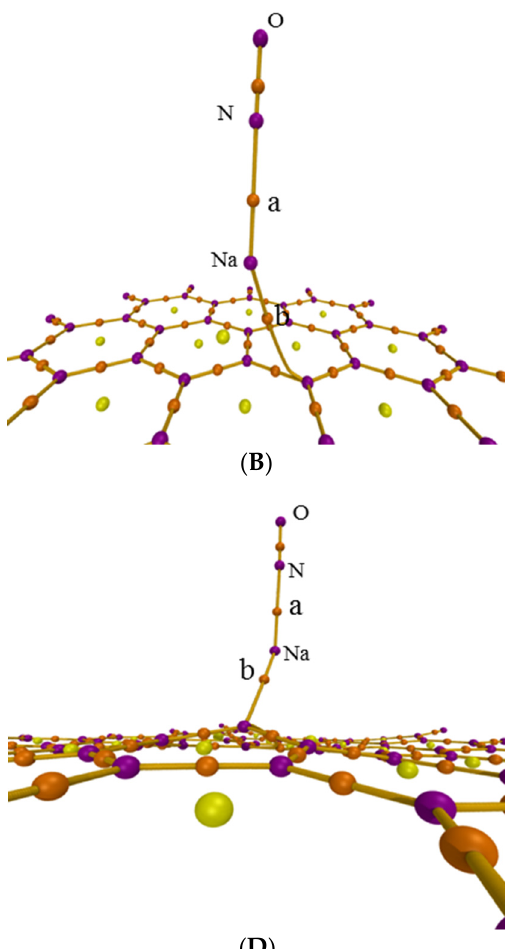
Figure 2. Optimized structure of ( a ) graphene-NO, ( b ) graphene-Na-NO, ( c ) gsv-NO, and ( d ) gsv-Na-NO. (The gray solid spheres indicate that the graphene surface and the purple, red, and blue spheres represent sodium, oxygen and nitrogen atoms, respectively.)